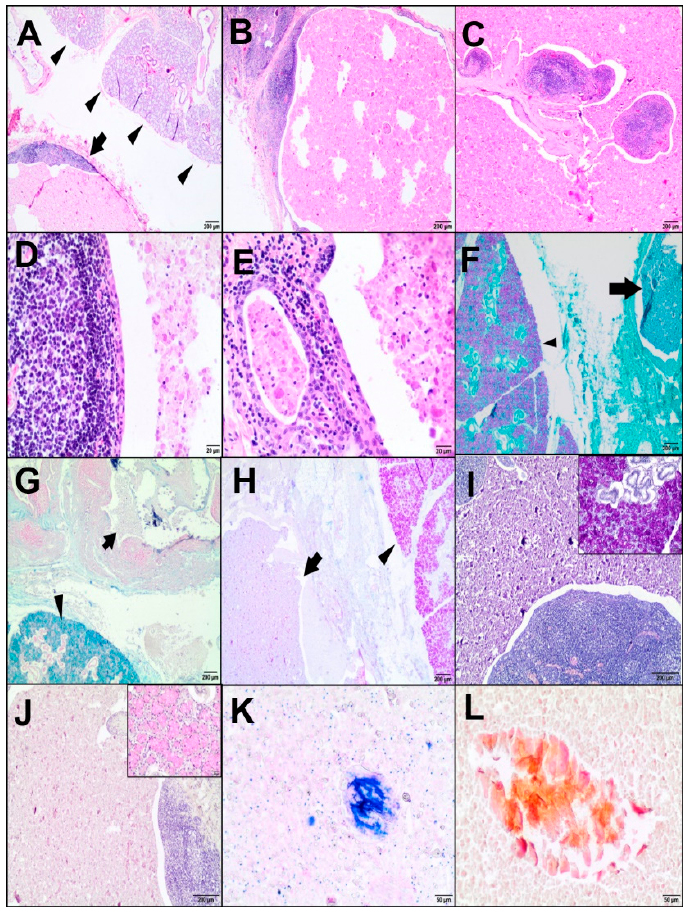
Figure 1. Histopathological ( A – E ) and histochemical examinations ( F – L ) of the lymphoepithelial cyst (LEC). ( A ) The LEC (arrow) close to the salivary gland (arrowheads). Haematoxylin-eosin staining (HE), 20 × ; scale bar = 200 µ m. ( B ) The cystic cavity with eosinophilic material surrounded by lymphoid tissue. HE, 20 × ; scale bar = 200 µ m. ( C ) Thin fibrous bands containing subepithelial lymphoid tissue. HE, 20 × ; scale bar = 200 µ m. ( D ) The cyst lined by squamous epithelium: small lymphoid follicles with a germinal centre beneath the lining of the epithelium. HE, 200 × ; scale bar = 20 µ m. ( E ) A ductal structure lined by cuboidal epithelium located beneath a cyst. HE, 200 × ; scale bar = 20 µ m. ( F ) Mucous acini positive for periodic acid Schi ff (PAS) (arrowhead, magenta colour). PAS-negative content of the cyst (arrow), 20 × ; scale bar = 200 µ m. ( G ) Mucous acini rich in acid mucopolysaccharides positive for alcian blue (AB) (arrowhead, blue). AB-negative content of the cyst (arrow), 20 × ; scale bar = 200 µ m. ( H ) PAS-AB-stained neutral mucins in the salivary glands (arrowhead, magenta). PAS-AB-negative cystic content (arrow), 20 × ; scale bar = 200 µ m. ( I ) The cystic content negative for PAS-diastase (PAS / D), 40 × ; scale bar = 200 µ m. Inset: Acinar cells magenta-coloured in PAS / D, 100 × ; scale bar = 50 µ m. ( J ) The cystic content negative for mucicarmine, 40 × ; scale bar = 200 µ m. Inset: Acinar cells positive for mucicarmine (pink), 200 × ; scale bar = 20 µ m. ( K ) Crystalloids (blue). May-Grünwald-Giemsa (MGG), 100 × ; scale bar = 50 µ m. ( L ) Orangeophilic-stained crystalloids in the cystic cavity. Pap, 100 × ; scale bar = 50 µ